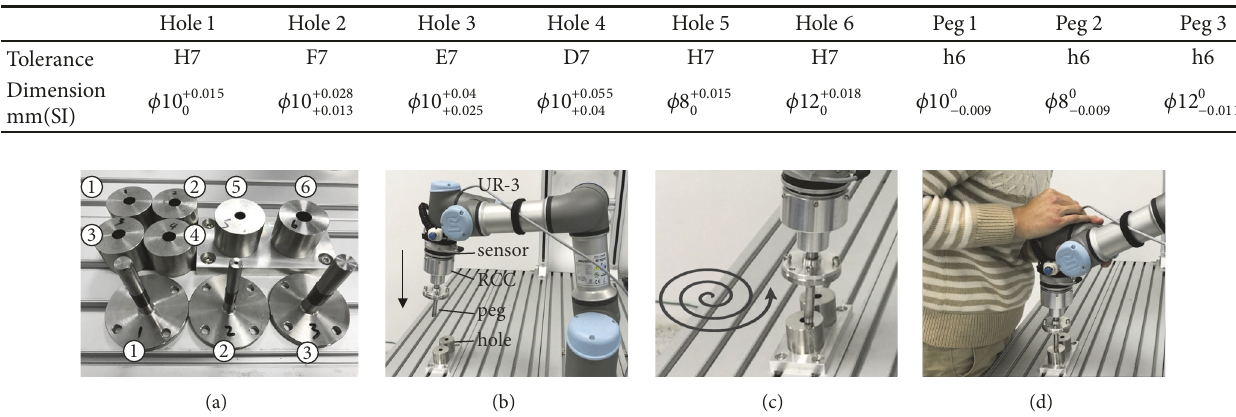
Figure 13: Experiment setup and demonstration phase by collaborative insertions. (a) The three pegs and six holes. (b) The peg is moving towards the hole. (c) Searching the hole by an Archimedean spiral movement. (d) Collaborative insertions. of the end-effector to enable a free-drive mode of the UR arm, which was implemented by joint torque estimation and allowed the demonstrator to guide the peg into the hole, as shown in Figure